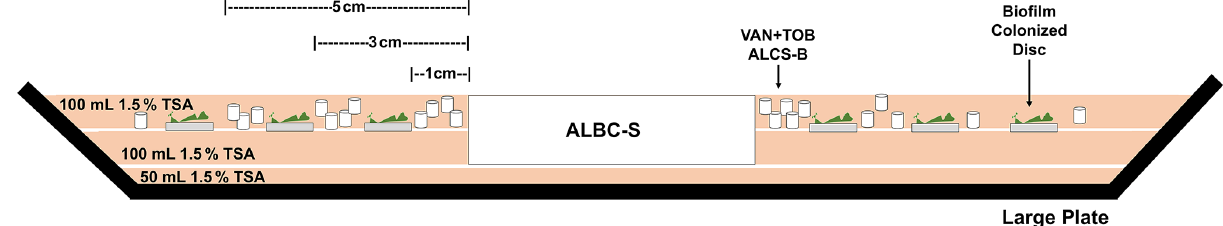
Figure 1. Side-view schematic showing the construction of the large plate agar model. This model allows for the spread of antibiotic released from ALCS-B and an antibiotic-loaded spacer (ALBC-S) as it diffuses through the agar. Three discs of each material containing 3d biofilms were placed at distances of 1, 3, and 5cm radiating linearly from the edge of the PMMA spacer mimic. ALCS-B were only included in the LS + ALCS-B antibiotic condition.